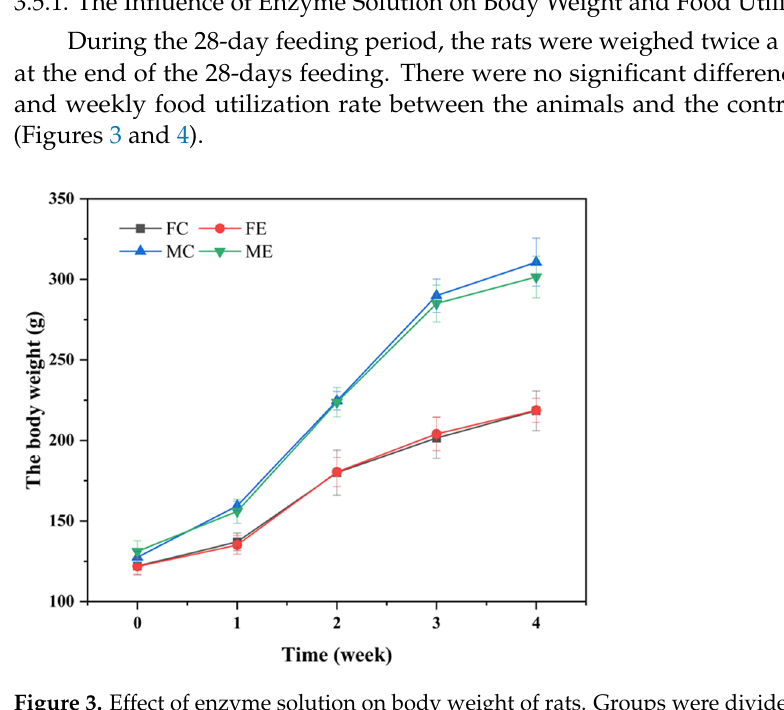
Figure 3. Effect of enzyme solution on body weight of rats. Groups were divided into Female control group (FC), Female enzyme group (FE), Male control group (MC), Male enzyme group (ME).